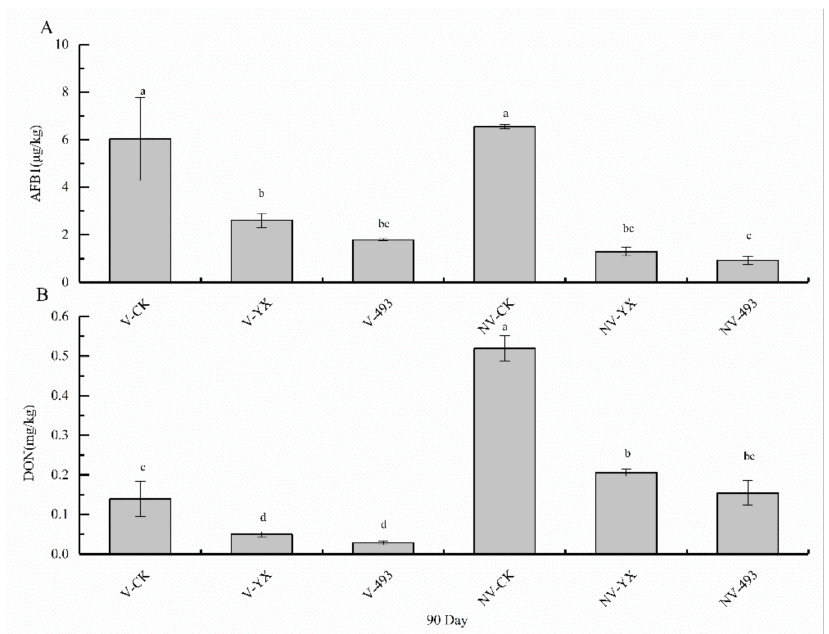
Figure 4. AFB1 ( A ) and DON ( B ) contents of alfalfa silage with different treatments at 90 days. CK, control; V, vacuum treatment; YX, inoculated with YX; 493, inoculated with Lactobacillus plantarum ZZUA493; NV, nonvacuum treatment. Different lowercase letters indicate a significant difference between samples ( p <